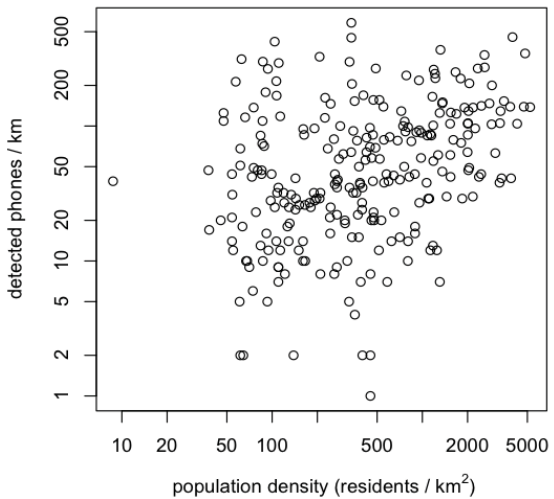
Figure 6. Scatter plot of statistical population density versus number of detected phones over each 1 km long segment of the